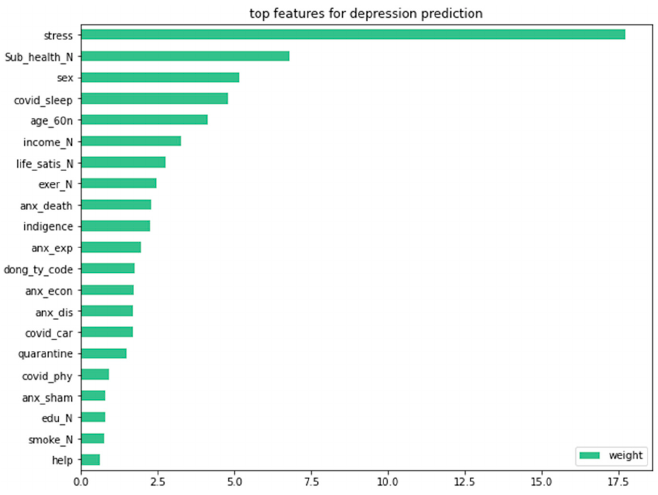
Figure 2. Example of an elderly individual with depression experience.